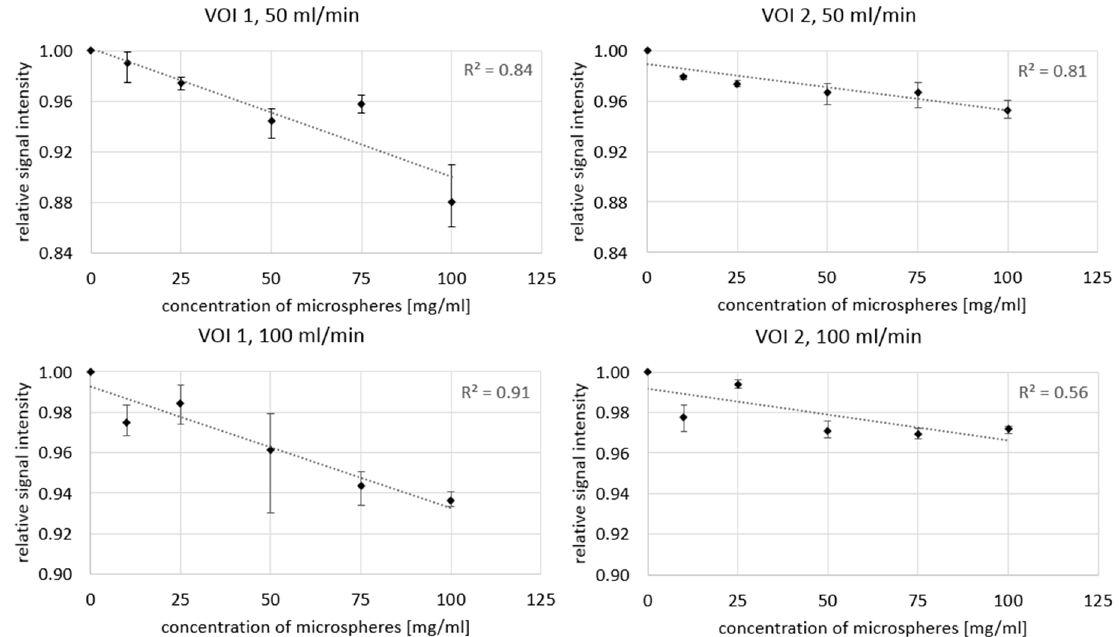
Figure 7. The lowest intensity value found in each of the intensity curves per injected concentration of holmium-165 microspheres (mean, error bars represent total range).